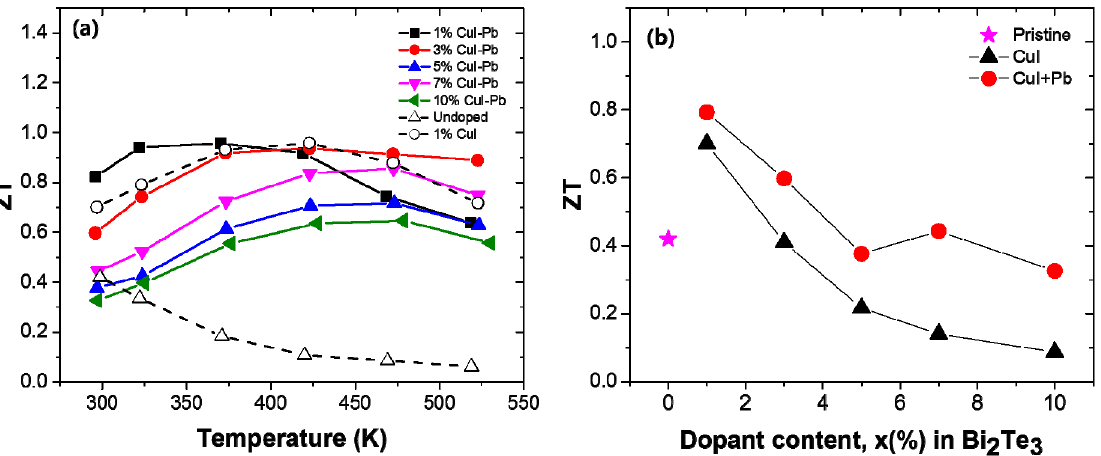
Figure 5. ( a ) Temperature dependency; and ( b ) Dopant content dependency of the room temperature ZT for x % CuI-Pb co-doped Bi 2 Te 3 ( x = 0.01, 0.03, 0.05, 0.07, and 0.10), 1% CuI-doped Bi 2 Te 3 , and undoped Bi 2 Te 3